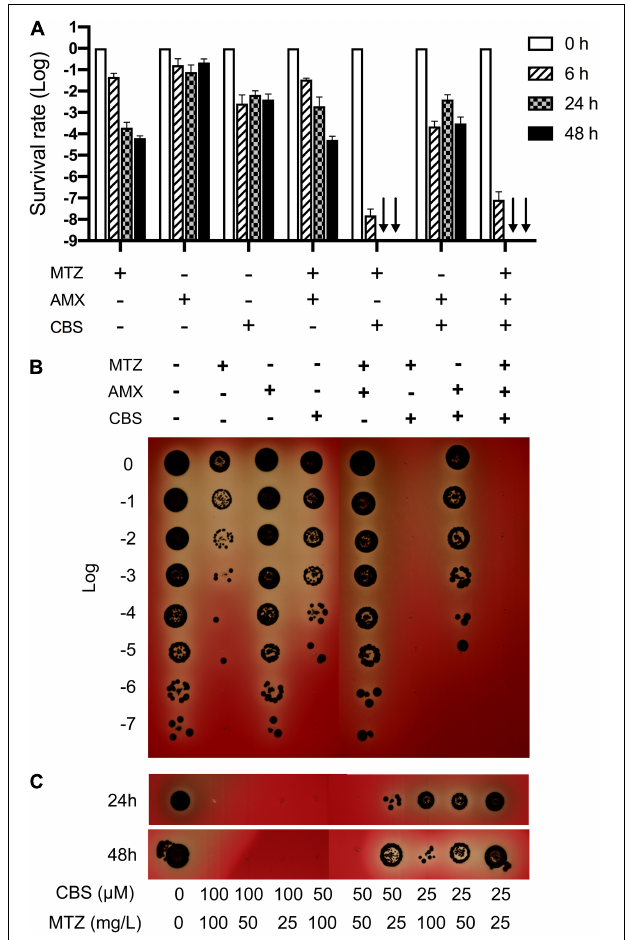
FIGURE 2 | CBS plus MTZ eradicated P. gingivalis persisters in planktonic mode. (A) The survival rate of P. gingivalis persisters after treatments with MTZ (100 mg/L), AMX (100 mg/L), and CBS (100 µ M) or different combinations of these medications for 6, 24, and 48 h, respectively. Data represent the mean ± SD of three independent experiments. Black arrows: not detected. (B) Plate culture of P. gingivalis persisters after 24-h treatment. (C) Combined usage of CBS and MTZ against P. gingivalis persisters with different concentrations of the drugs. (B,C) Show one randomly chosen result from three independent